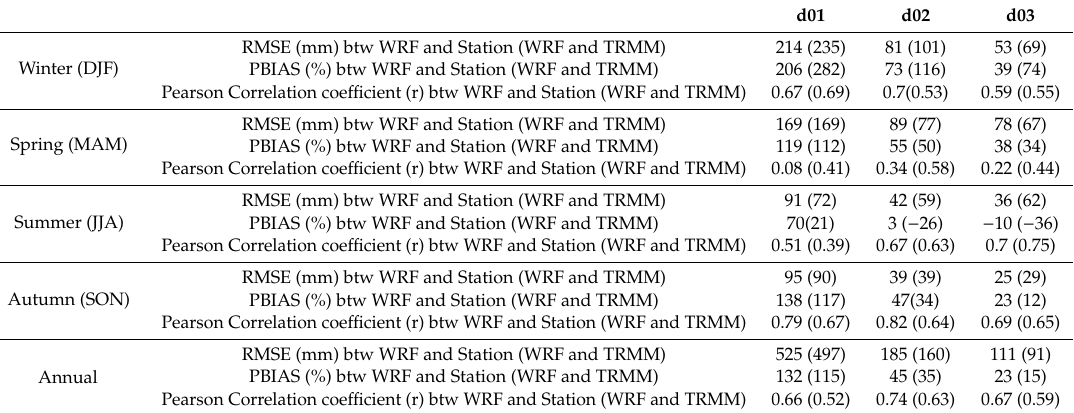
Table 3. Mean RMSE (mm), percentage di ff erence (%), and Pearson correlation coe ffi cient (r; unitless) of precipitation between WRF, stations, and TRMM in d01, d02, and d03.